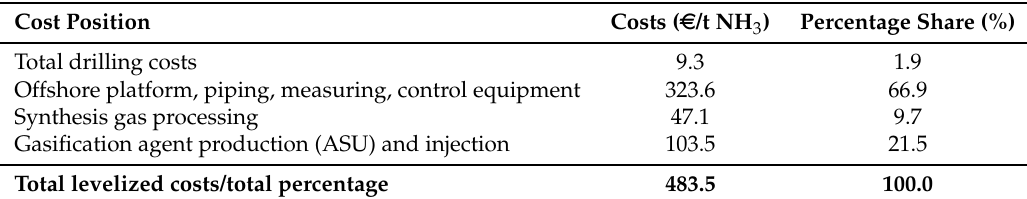
Table 17. Share of individual cost positions on levelized offshore ammonia production costs.